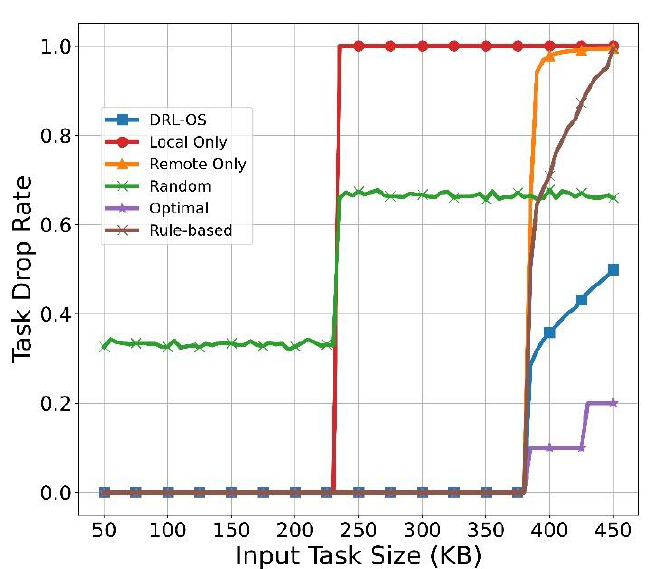
Figure 10. Task drop rate vs. input task size.